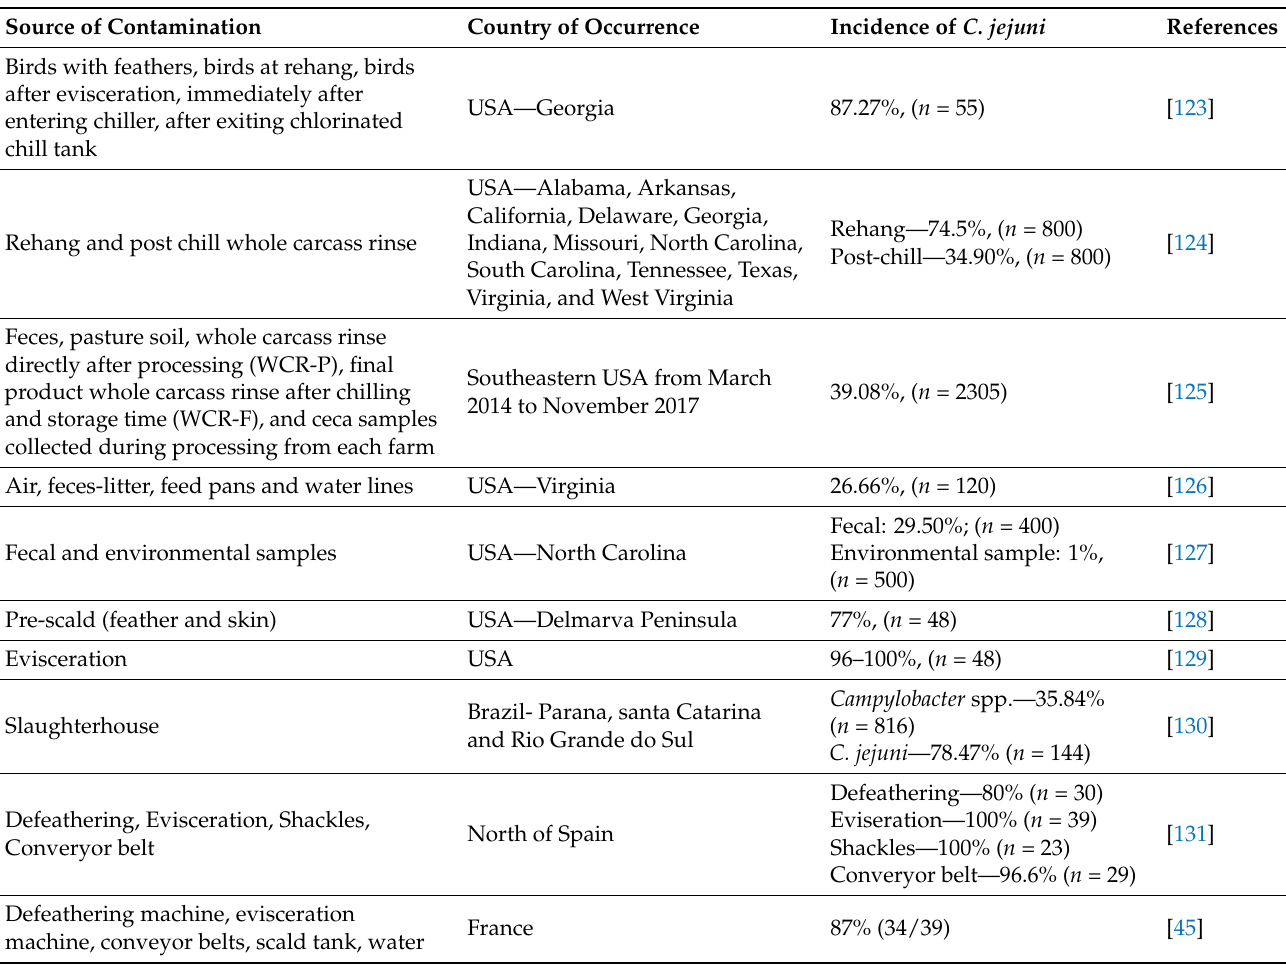
Table 1. Incidence of Campylobacter jejuni at various stages inside processing plants.